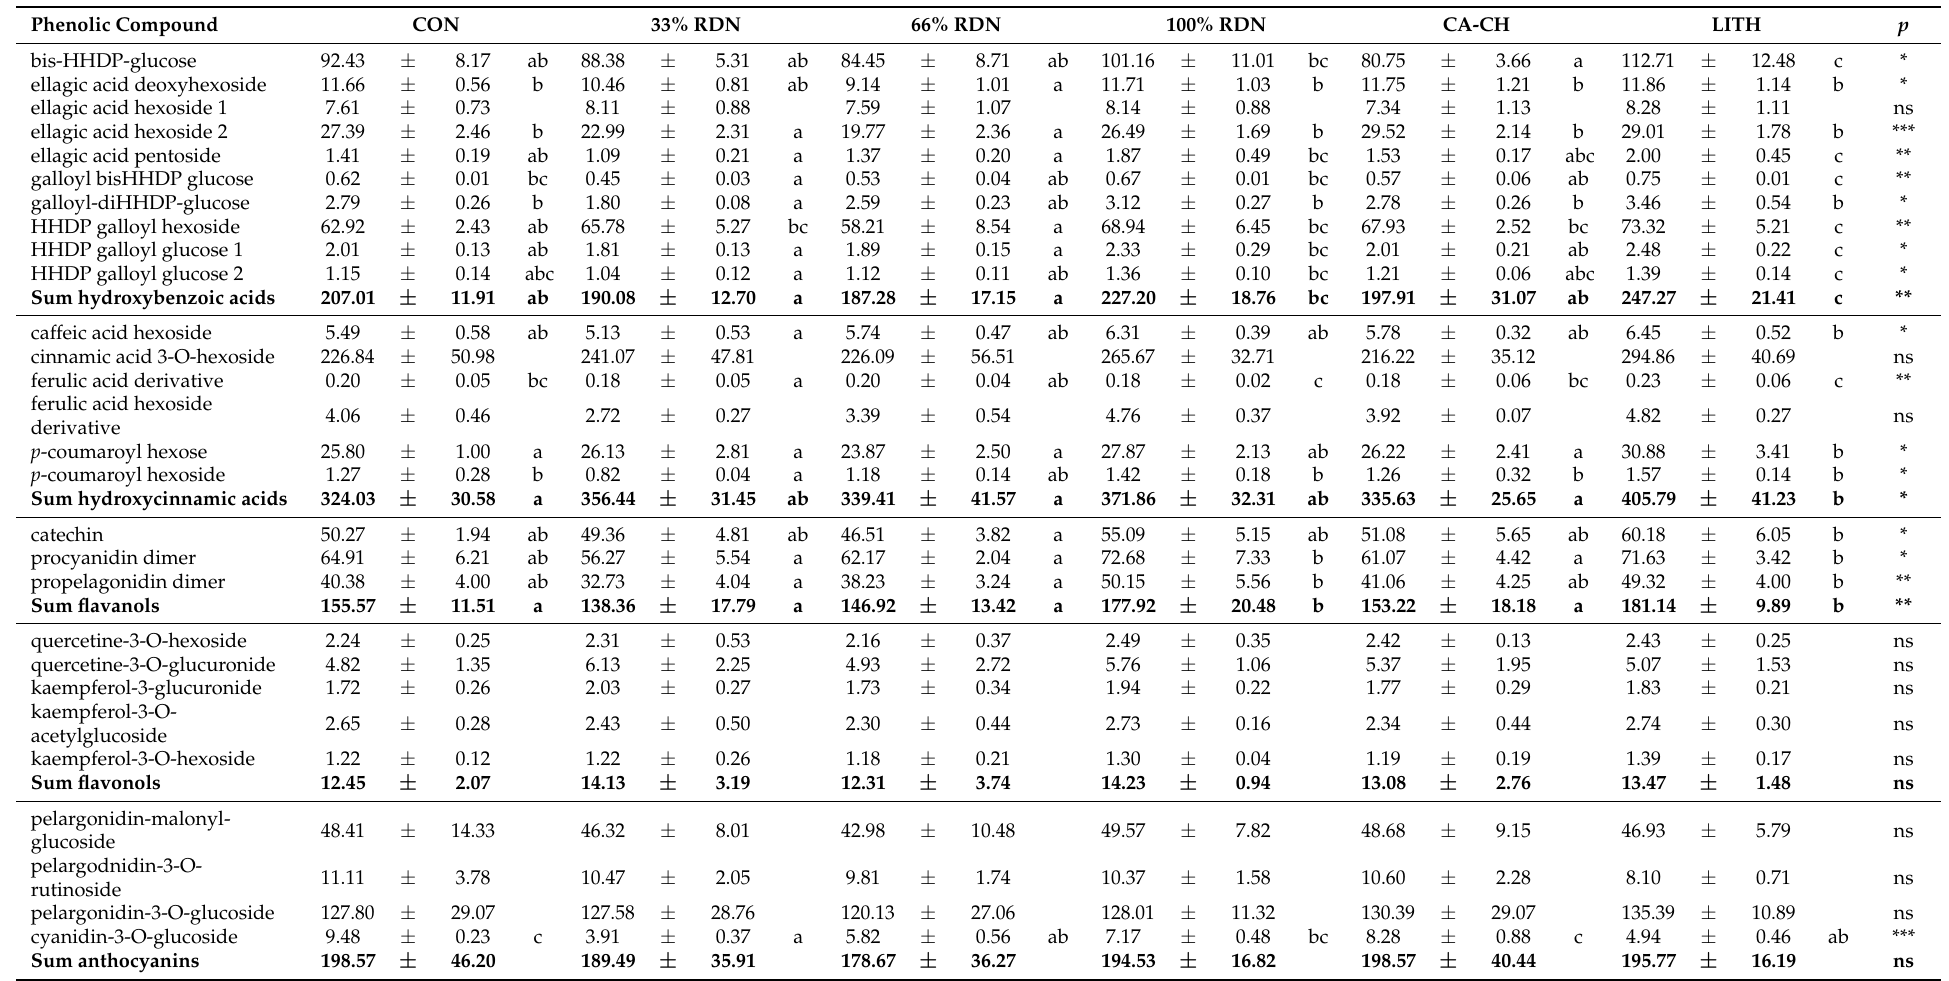
Table 2. Content of individual phenolic compounds in strawberries subjected to six treatments (CON, 33%, 66% and 100% RDN, CA-CH and LITH). Phenolic